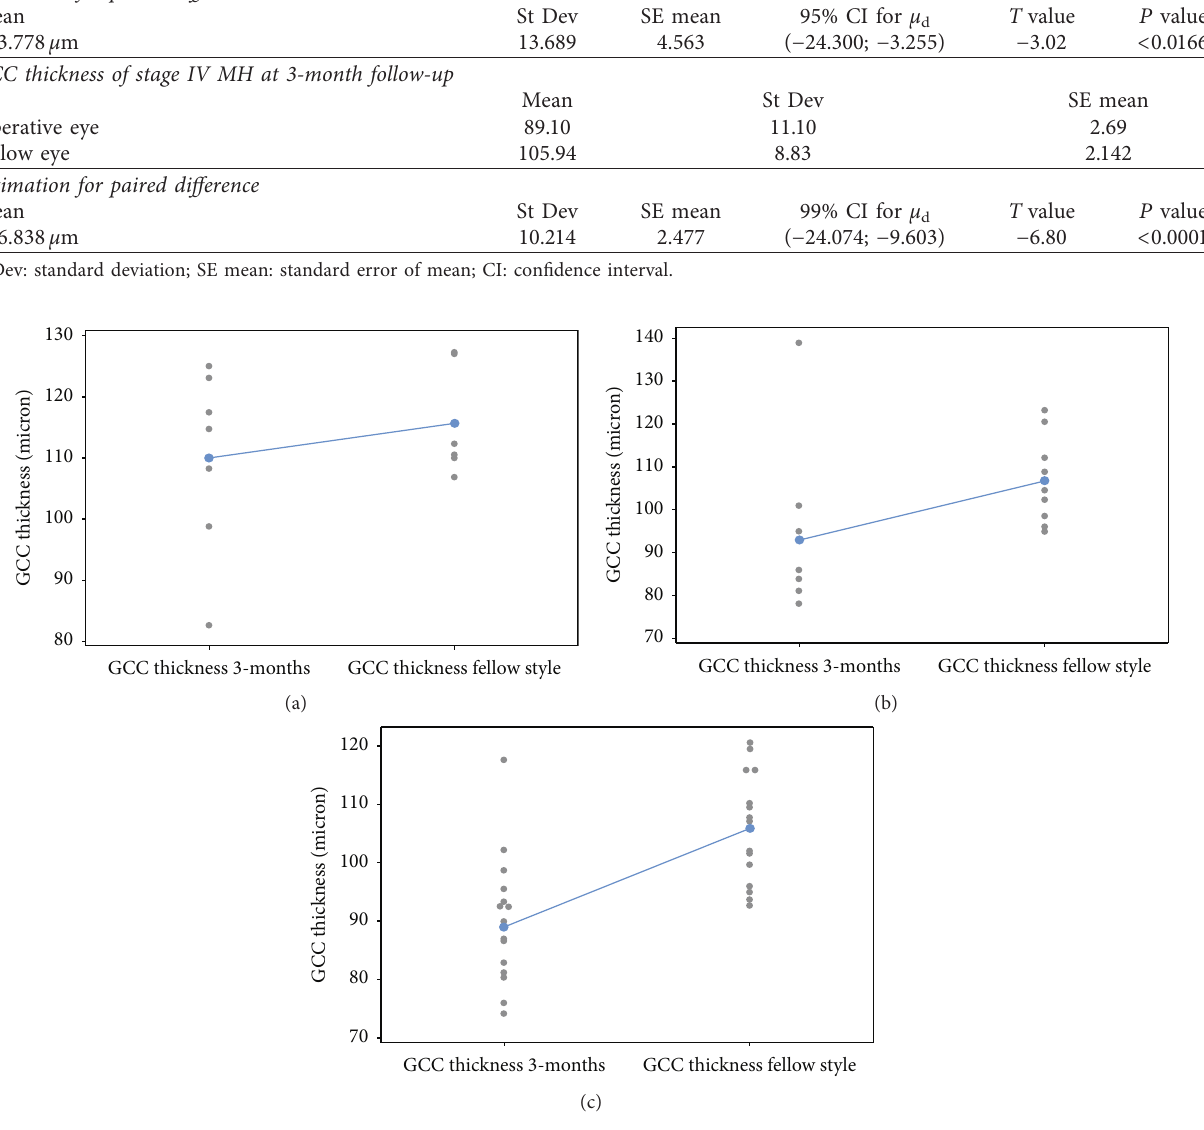
Figure 8: Comparison between GCC thickness of the operated eye and contralateral healthy eye in the three groups at three-month follow up: (a) macular hole stage I, (b) macular hole stage II, and (c) macular hole stage